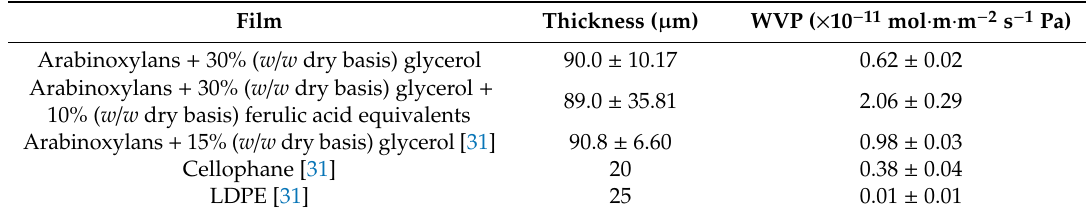
Table 6. Water vapor permeability of arabinoxylan-based films and of commercial Cellophane and low density polyethylene (LDPE). WVP: water vapor permeability.